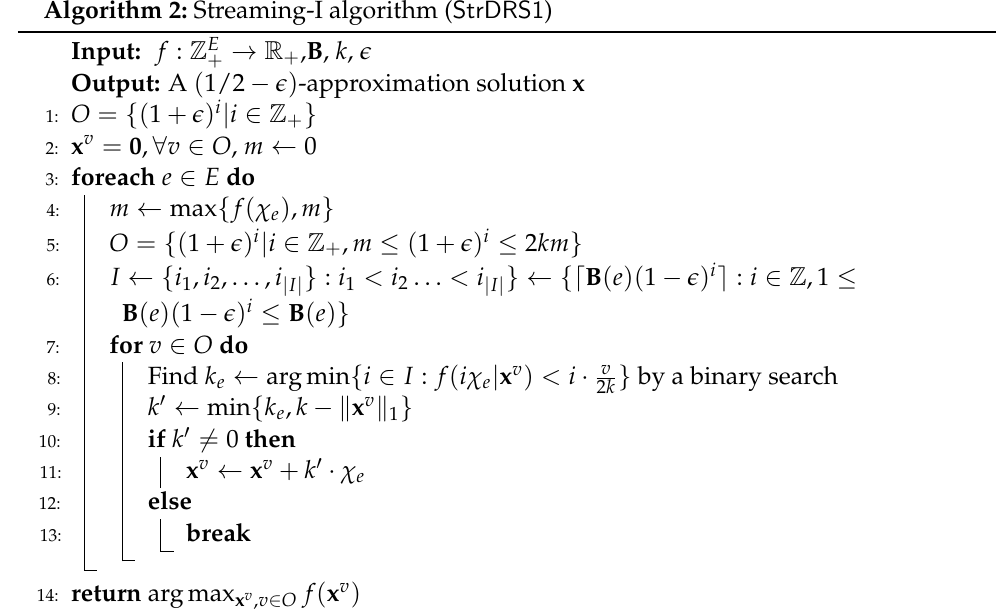
4.1.2. ( 1/2 − (cid:101) ) -Approximation Streaming Algorithm— StrDRS1 Algorithm